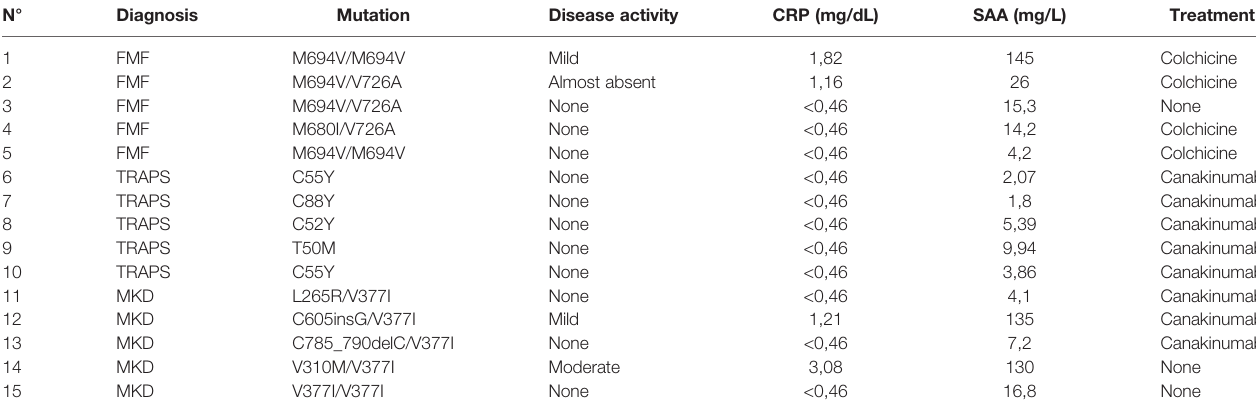
TABLE 1 | Characteristics of patients.